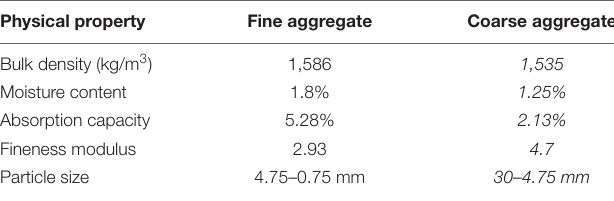
TABLE 3 | Physical properties of fine and coarse